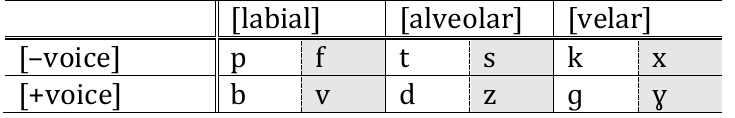
Table 2: Example